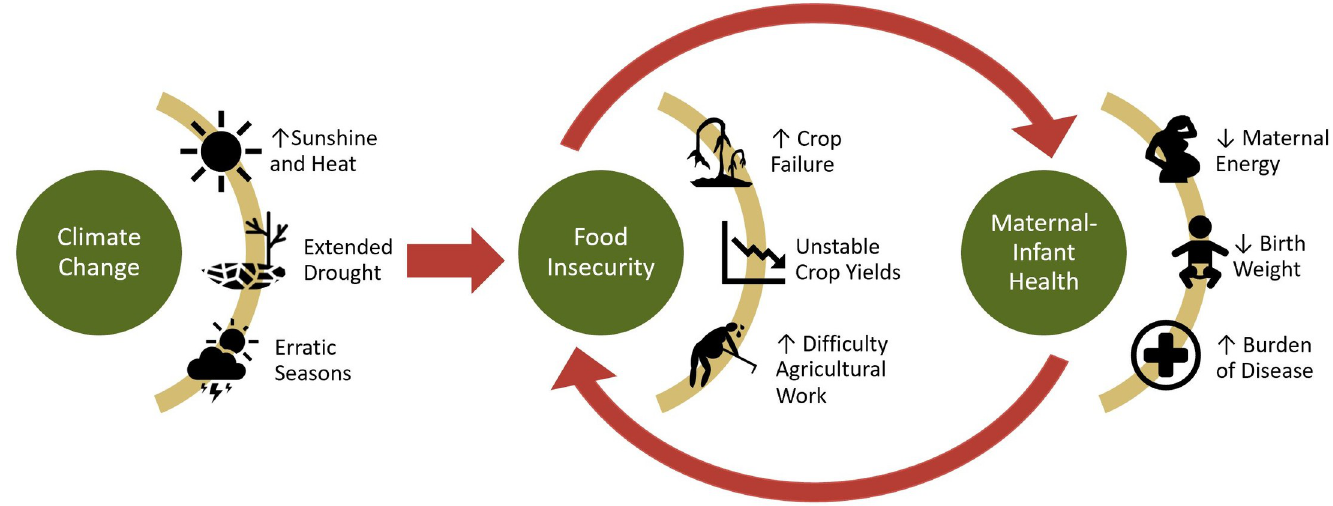
Fig 3. Pathways of climate change, food insecurity, and maternal-infant health reported by mothers in rural Uganda. https://doi.org/10.1371/journal.pone.0247198.g003 PLOS ONE | https://doi.org/10.1371/journal.pone.0247198 March 24,